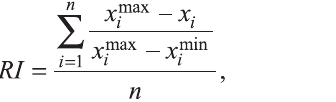
Table 5. Performance of predictive techniques for Analyses 1 and 2 Predictive Analysis